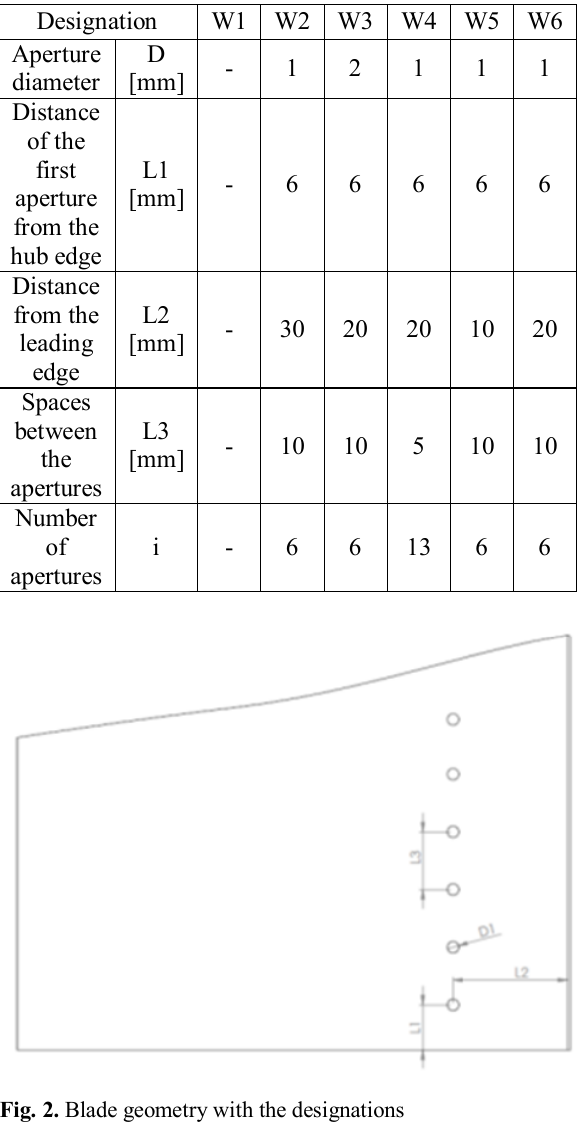
Table 1. Parameters of slot locations on a blade